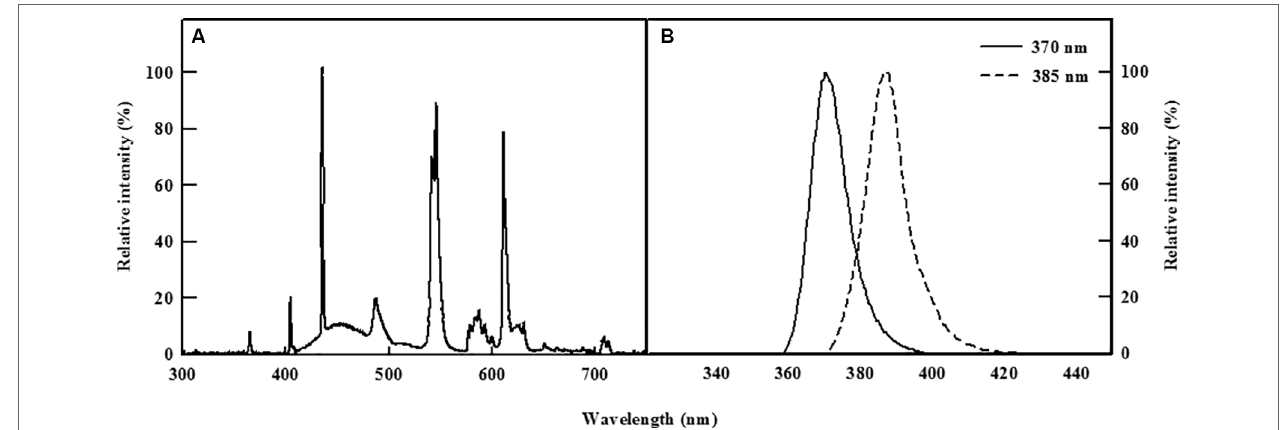
FIGURE 1 | Relative spectral distribution of the fluorescent lamp (A) and the two types of UV-A LEDs with 370 or 385 nm peak wavelength used (B)